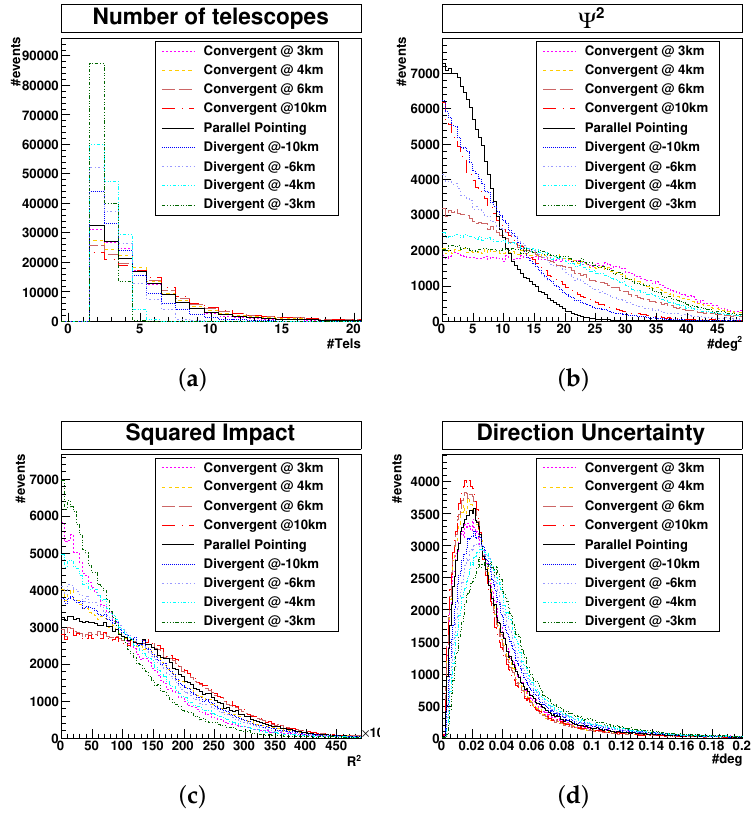
Figure 4. Comparison of performances of various pointing strategies. From left to right: ( a ) Event multiplicity, ( b ) Squared angular distance to optical axis, ( c ) Squared impact distance to the centre of the array, ( d ) Event reconstruction precision, measured as the fit uncertainty on the event